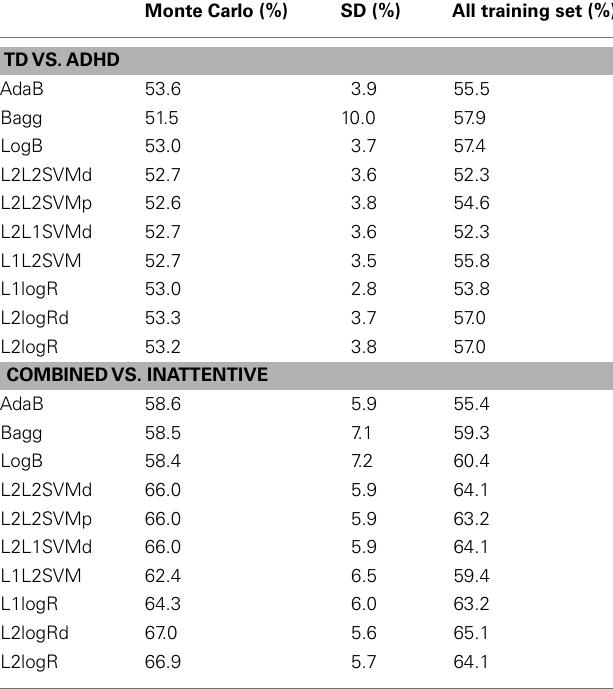
Table 2 | Classification scores (sensitivity + specificity)/2 of the mean from Monte Carlo subsampling scores (and respective standard deviation) and when training the classifiers using all released training sample (759 subjects) and predicting the released test sample (170